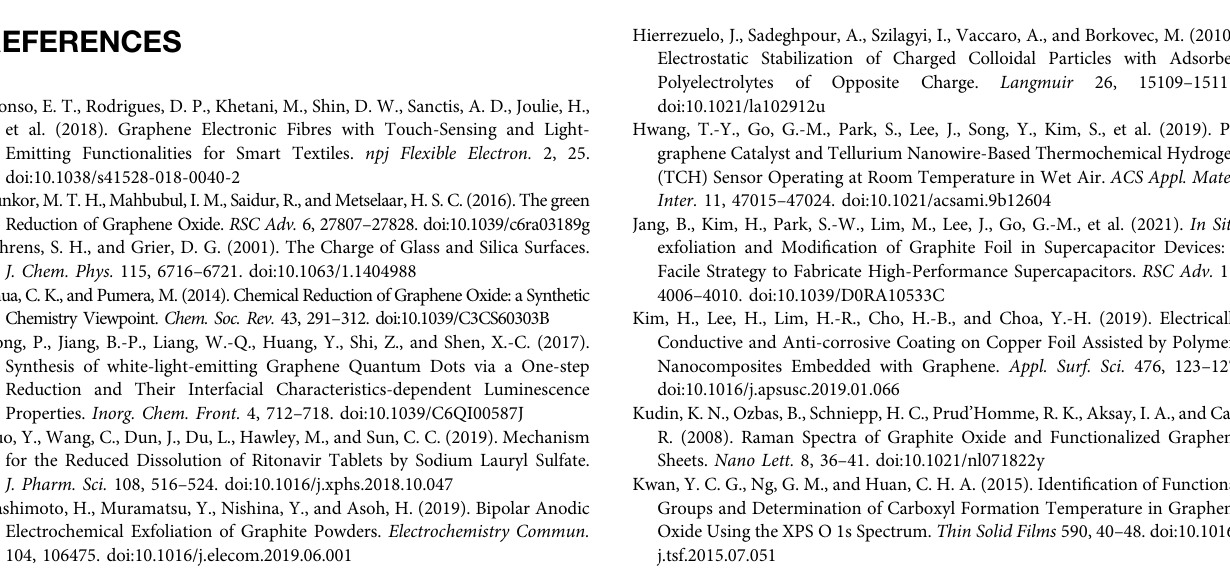
Frontiers in Chemistry |